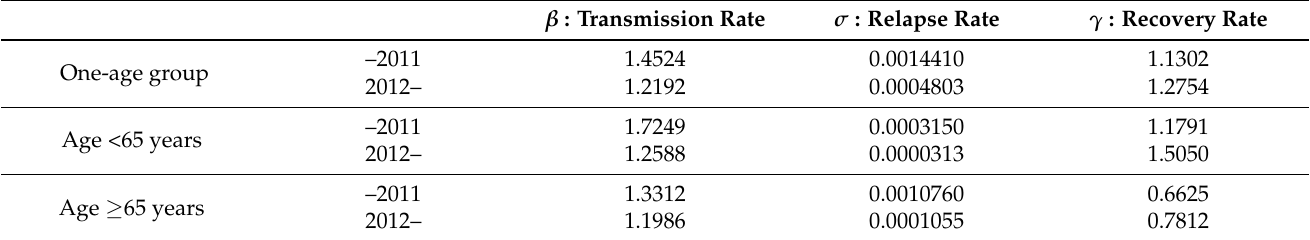
Table 6. Parameter estimation for a 2-time window (2001 to 2011 and 2012 to 2018). Age-specific transmission rates, relapse rates, and recovery rates were estimated according to TB incidence in South Korea.